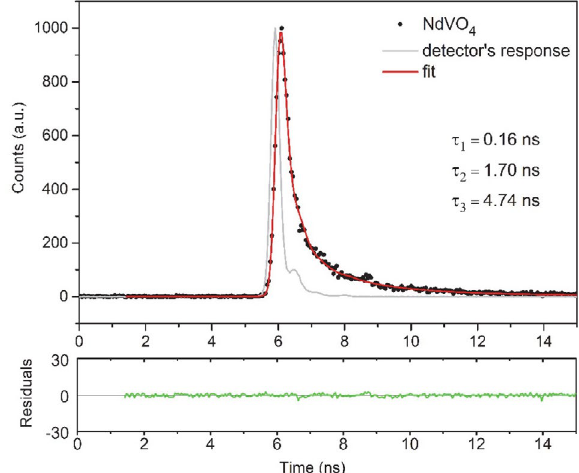
Fig. 9. Photoluminescence lifetime measured on the NdVO 4 na- noneedles, λ em = 524 nm. The black dots represent the time-domain intensity decay. The red line is the fitting curve, while the grey line is the response of the detector. The green line below represents the difference between the fitted curve and the measured data. The goodness of fit, χ 2 , is 1.418.